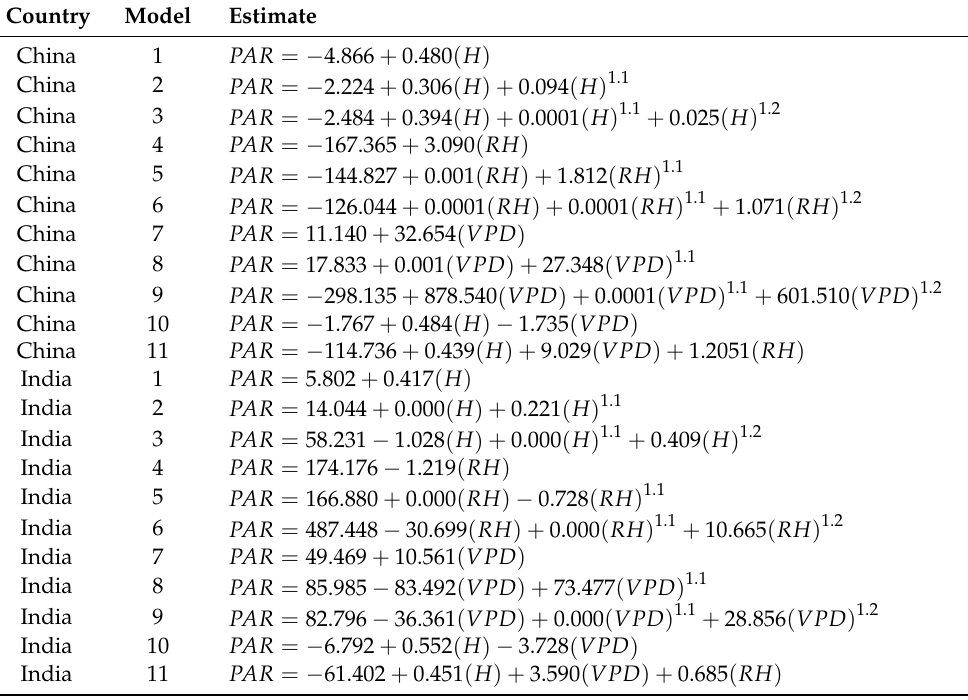
Table 4. Fitted empirical models for predicting PAR productivity in China and